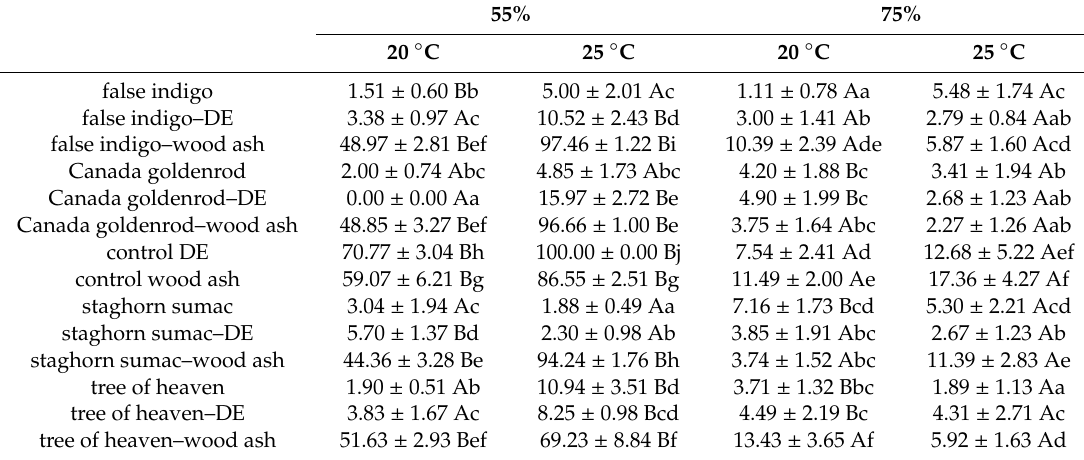
Table 7. Mean mortality (% ± SE) of Sitophilus oryzae exposed to di ff erent treatments for 14 days.